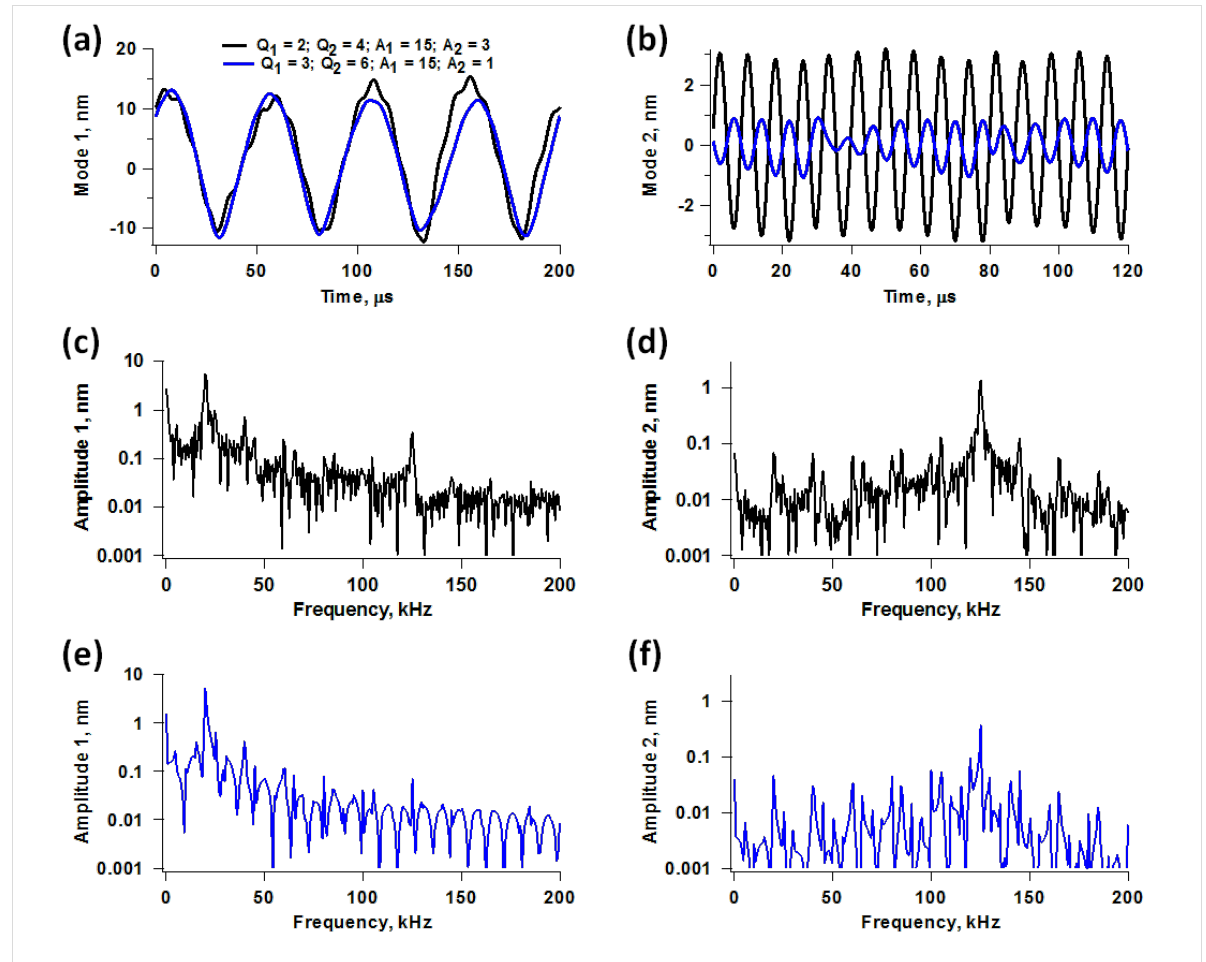
Figure 3: Illustration of eigenmode perturbation for two different cases. The results are color coded for the two cases considered, Q 1 = 2, Q 2 = 4, A 1 = 15 nm and A 2 = 3 nm for case 1 (black traces), and Q 1 = 3, Q 2 = 6, A 1 = 15 nm and A 2 = 1 nm for case 2 (blue traces). (a) mode 1 responses in time space; (b) mode 2 responses in time space; (c) and (d) mode 1 and mode 2 spectra, respectively, for case 1; (e) and (f) mode 1 and mode 2 spectra, respectively, for case 2. The amplitude setpoint is approximately 70% and the sample parameters are the same as for Figure 2. Notice how the use of a smaller value of A 2 results in a sharper spectrum for the first mode but a less sharp spectrum for the second mode, and vice-versa.